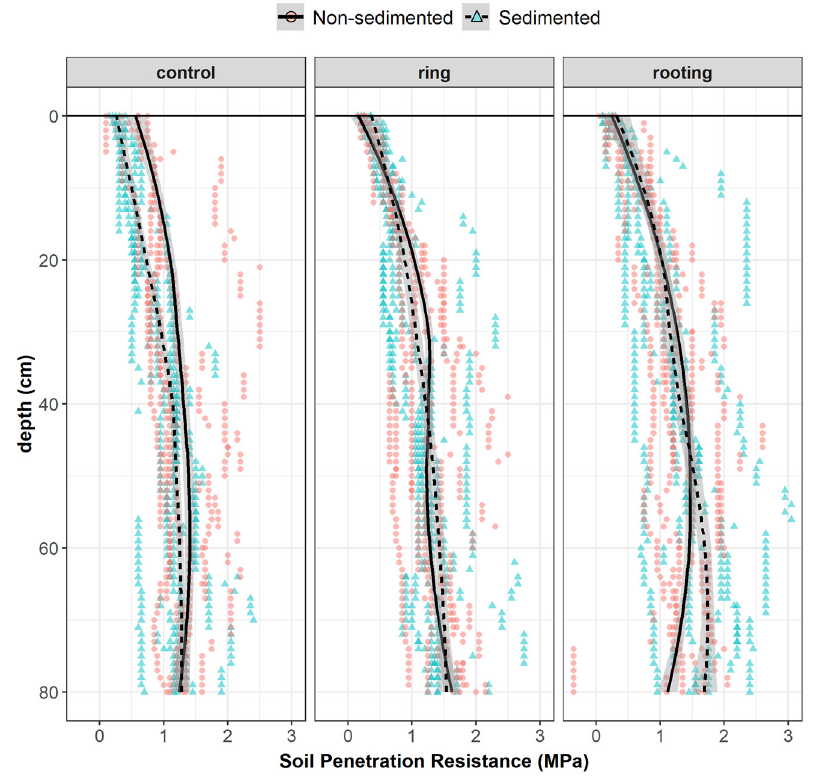
Figure 4. Soil penetration resistance in rooting, ring, and control areas in sedimented and non-sedimented soils. Dots represent observations from non-sedimented soils, while triangles from sedimented soils.